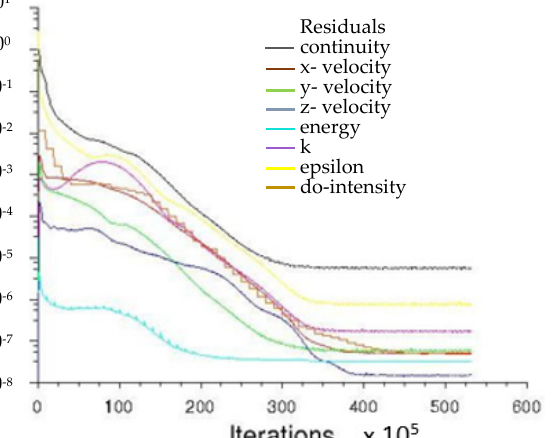
Figure 9. An example of the solution value for the measuring section (see Figure 8b) and Re = 9000.